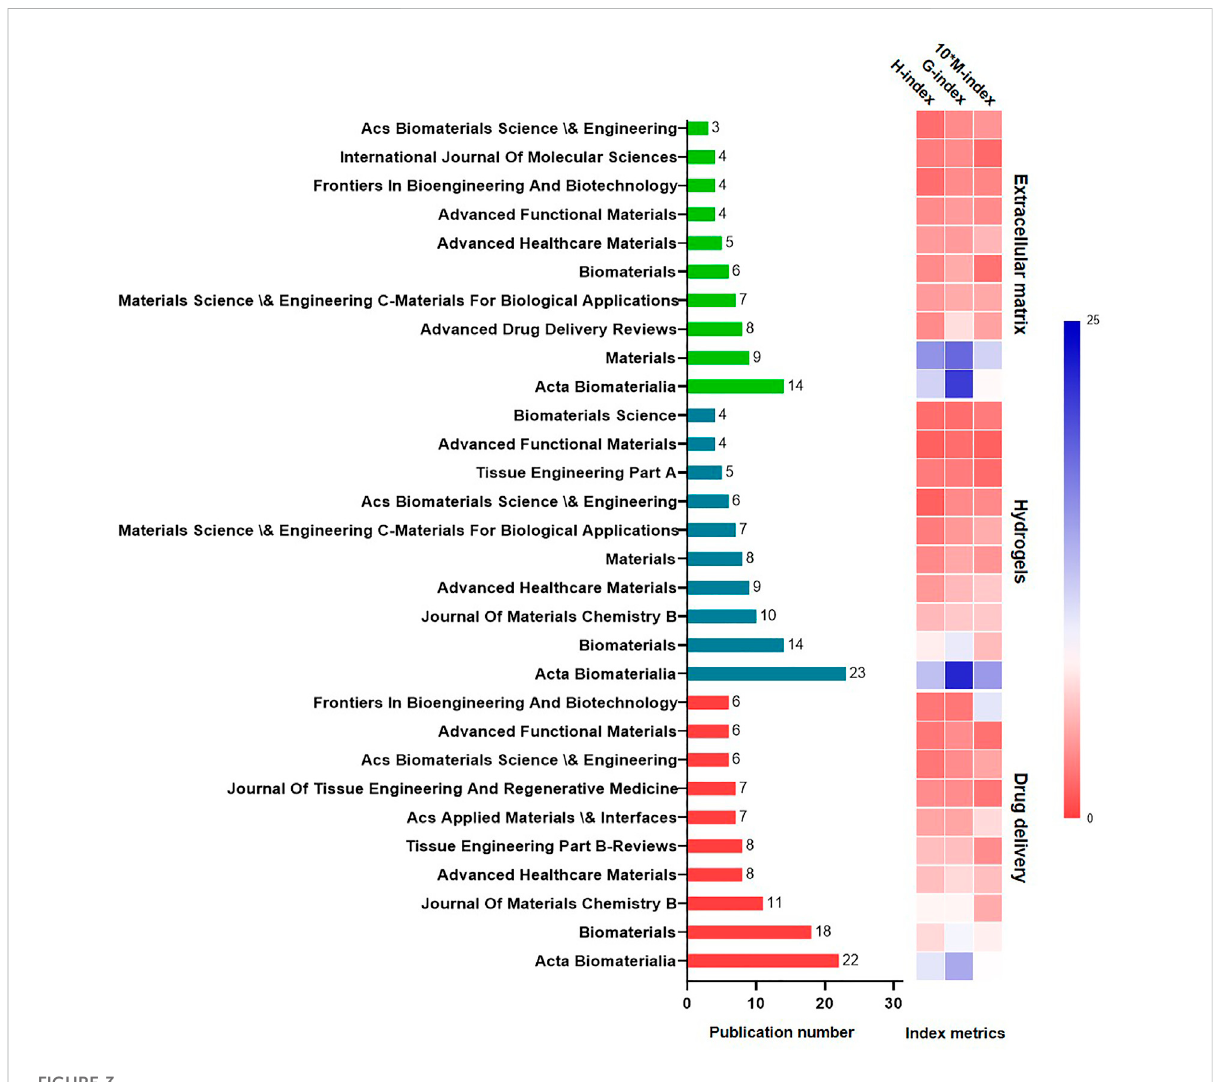
FIGURE 3 Publication number and index metrics for top 10 proli fi c journals.